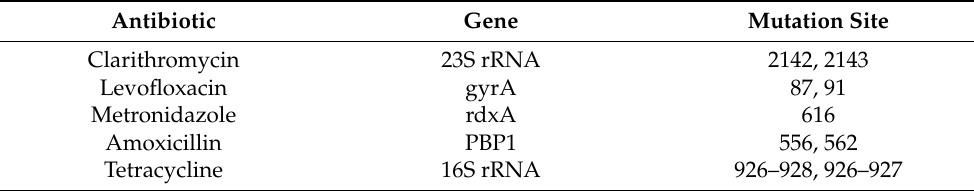
Table 1. Point mutations of H. pylori genes by gene chip detection.